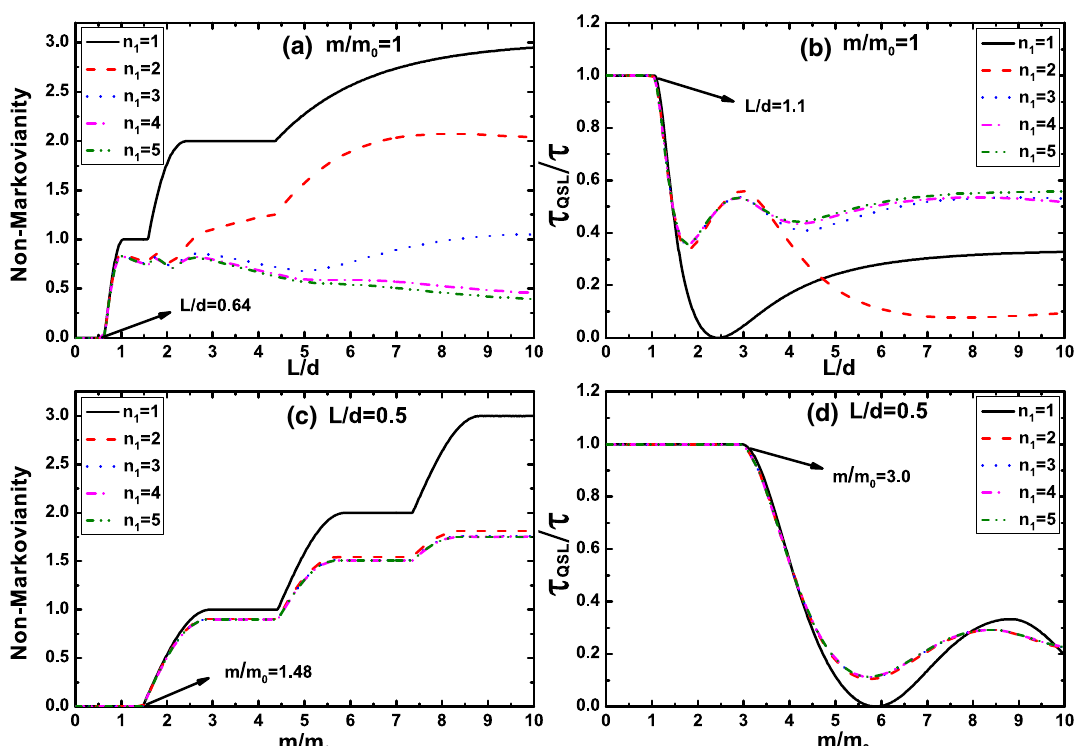
Fig. 2 For the one-side model, the actual evolution time τ = 0 . 4 s, d = 250 µ m and m 0 = 10 − 13 kg. a , c Non-Markovianity N (ϕ) of the dynamics process of the system particle m 0 as a function of L / d and